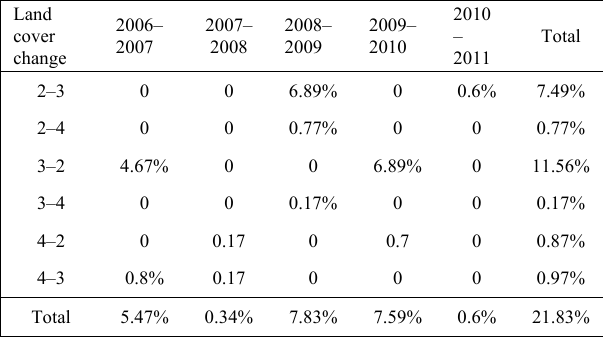
Table 5. Composition of land cover change in the selected